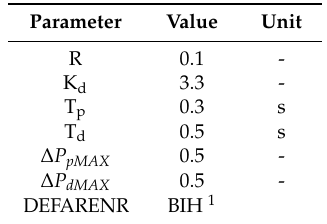
Table 5. FCPCAU1 parameter values.